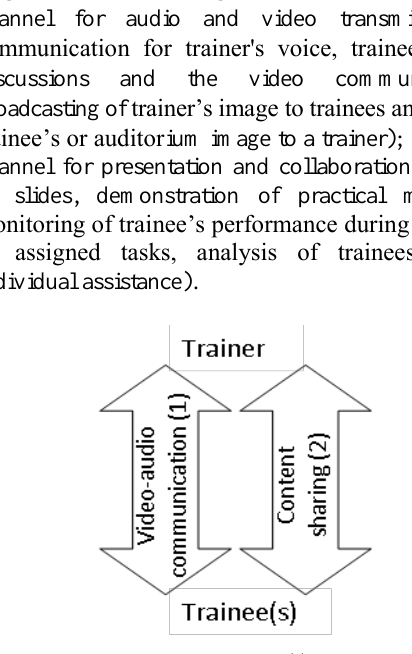
Fig. 1. Schematic diagram of Trainer-Trainee(s)